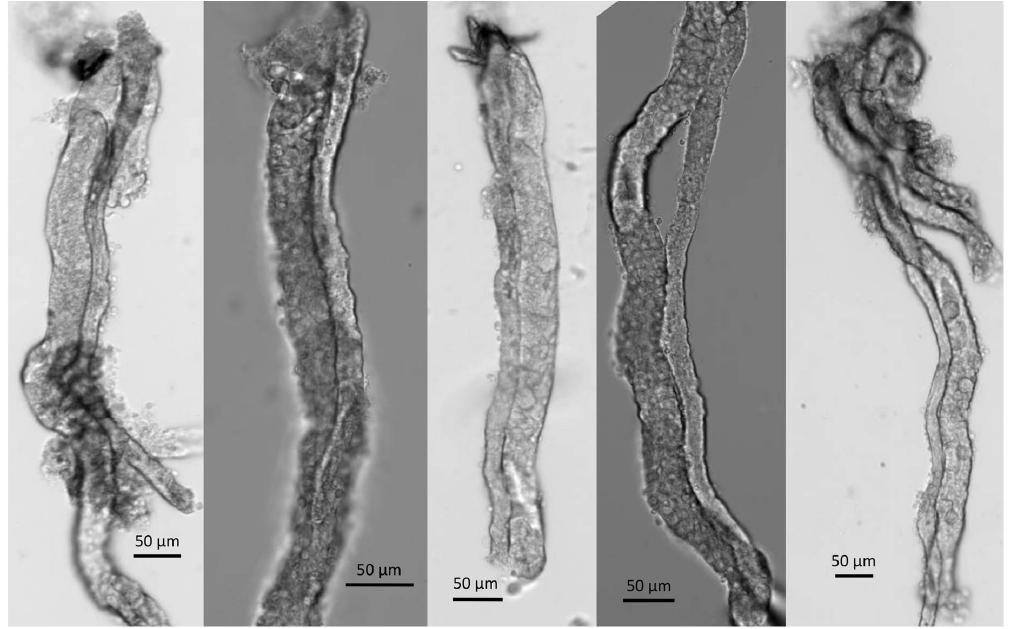
Figure 8. Examples of cTAL (thinner tubule) attached to the straight portion of the pars recta of the proximal tubule (thicker tubule).